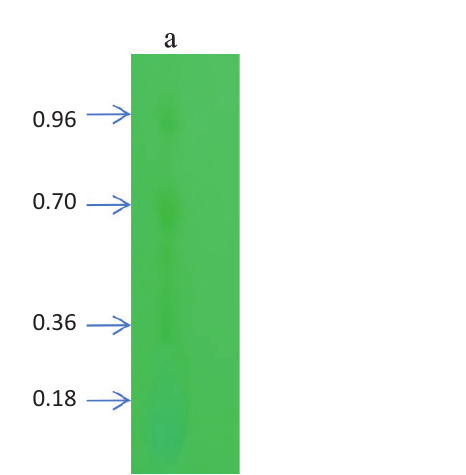
Fig. 2. TLC analysis in A. indica crude